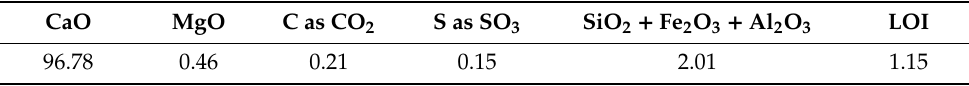
Table 3. Chemical composition of the lime used as a flux agent (% by